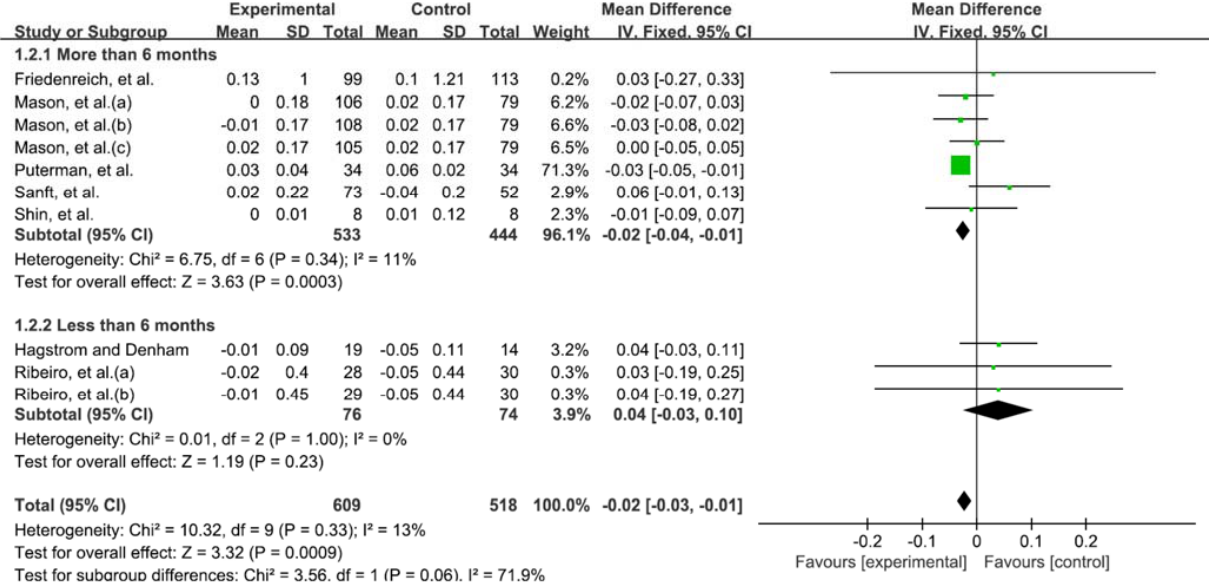
Figure 4. Forest plot on the effect of telomere length according to the duration of exercise. Mason et al., (a) aerobic exercise; (b) aerobic exercise and combinded training; (c) combinded training. Ribeiro et al., (a) continuous aerobic training; (b) intermittent aerobic training.